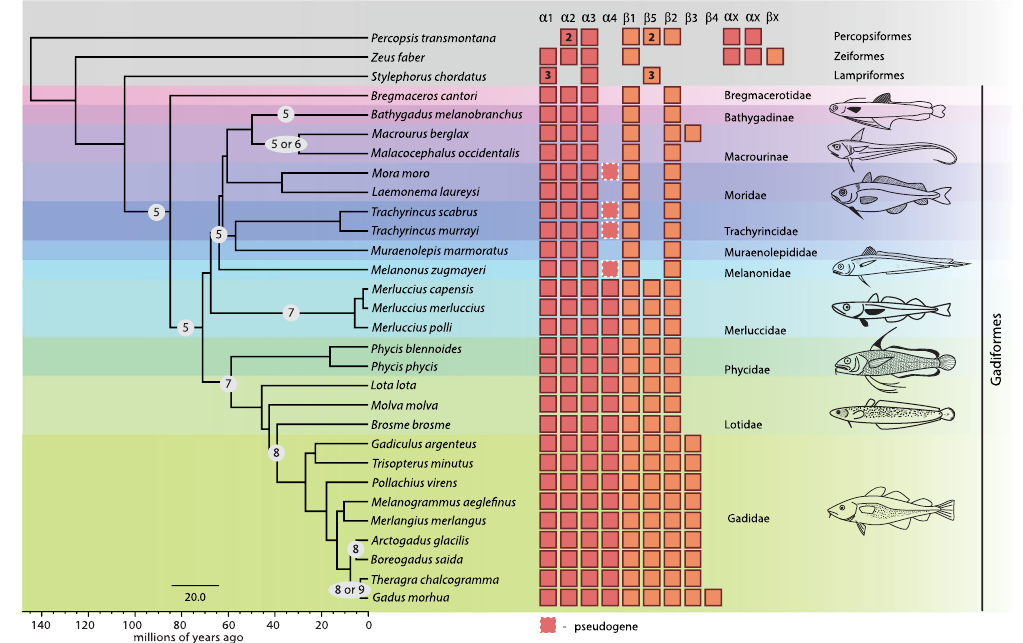
Figure 1. The repertoire of hemoglobin genes in the Gadiformes. The number of Hb s in 27 species of Gadiformes, as well as three outgroup species from Stylephoriformes, Zeiformes and Percopsiformes, are mapped onto a time-calibrated molecular phylogeny. This phylogeny is part of a larger teleost phylogeny presented in ref. 9. α - and β -globin genes are indicated by boxes. Some species have more than one copy of a gene, which is indicated by a number. α x and β x refer to α - and β genes that are not 1:1 orthologs to the gadiform Hb genes. The ancestral Hb copy number with the highest likelihood is indicated at nodes where there has been an evolutionary change, as well as any ambiguity (Supplementary Fig. 1). Time is given in million years. Fish illustrations drawn by Geir Holm are reprinted with permission from ref.